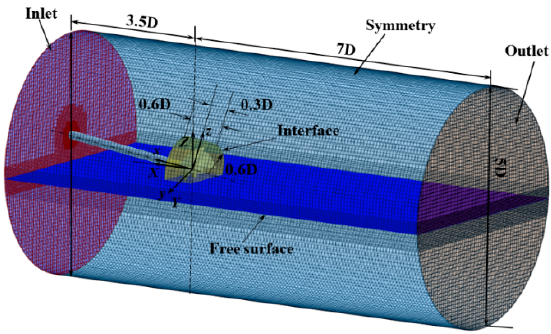
Figure 4. Computational domain and boundary conditions.